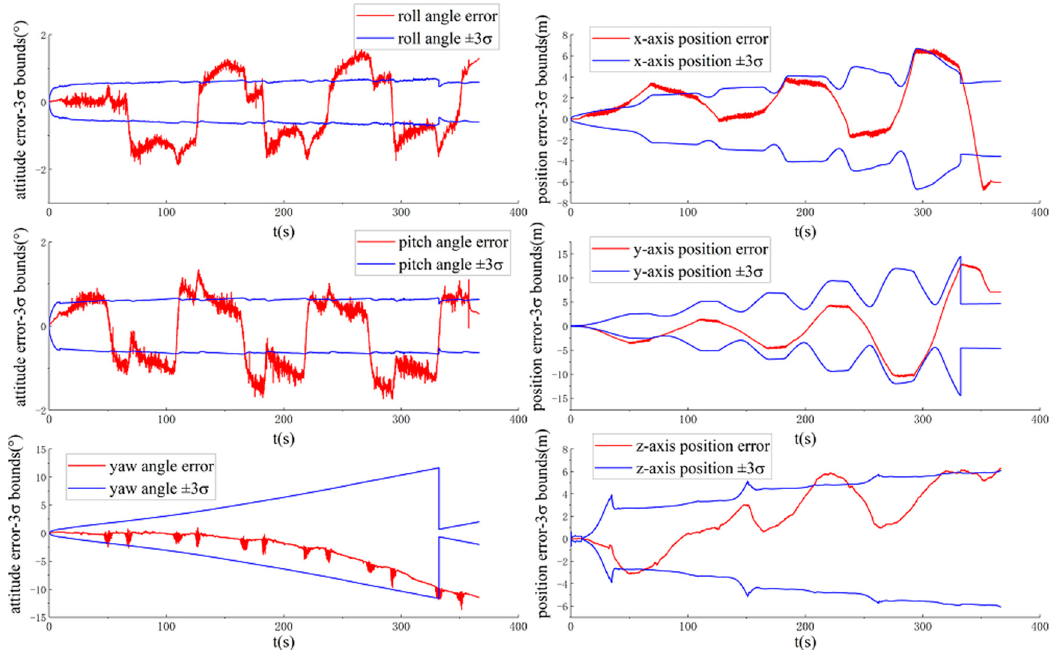
Figure 8. The ground-truth pose errors and estimated ± 3 σ bounds of MAVIO(1) with time for the VD06 dataset.